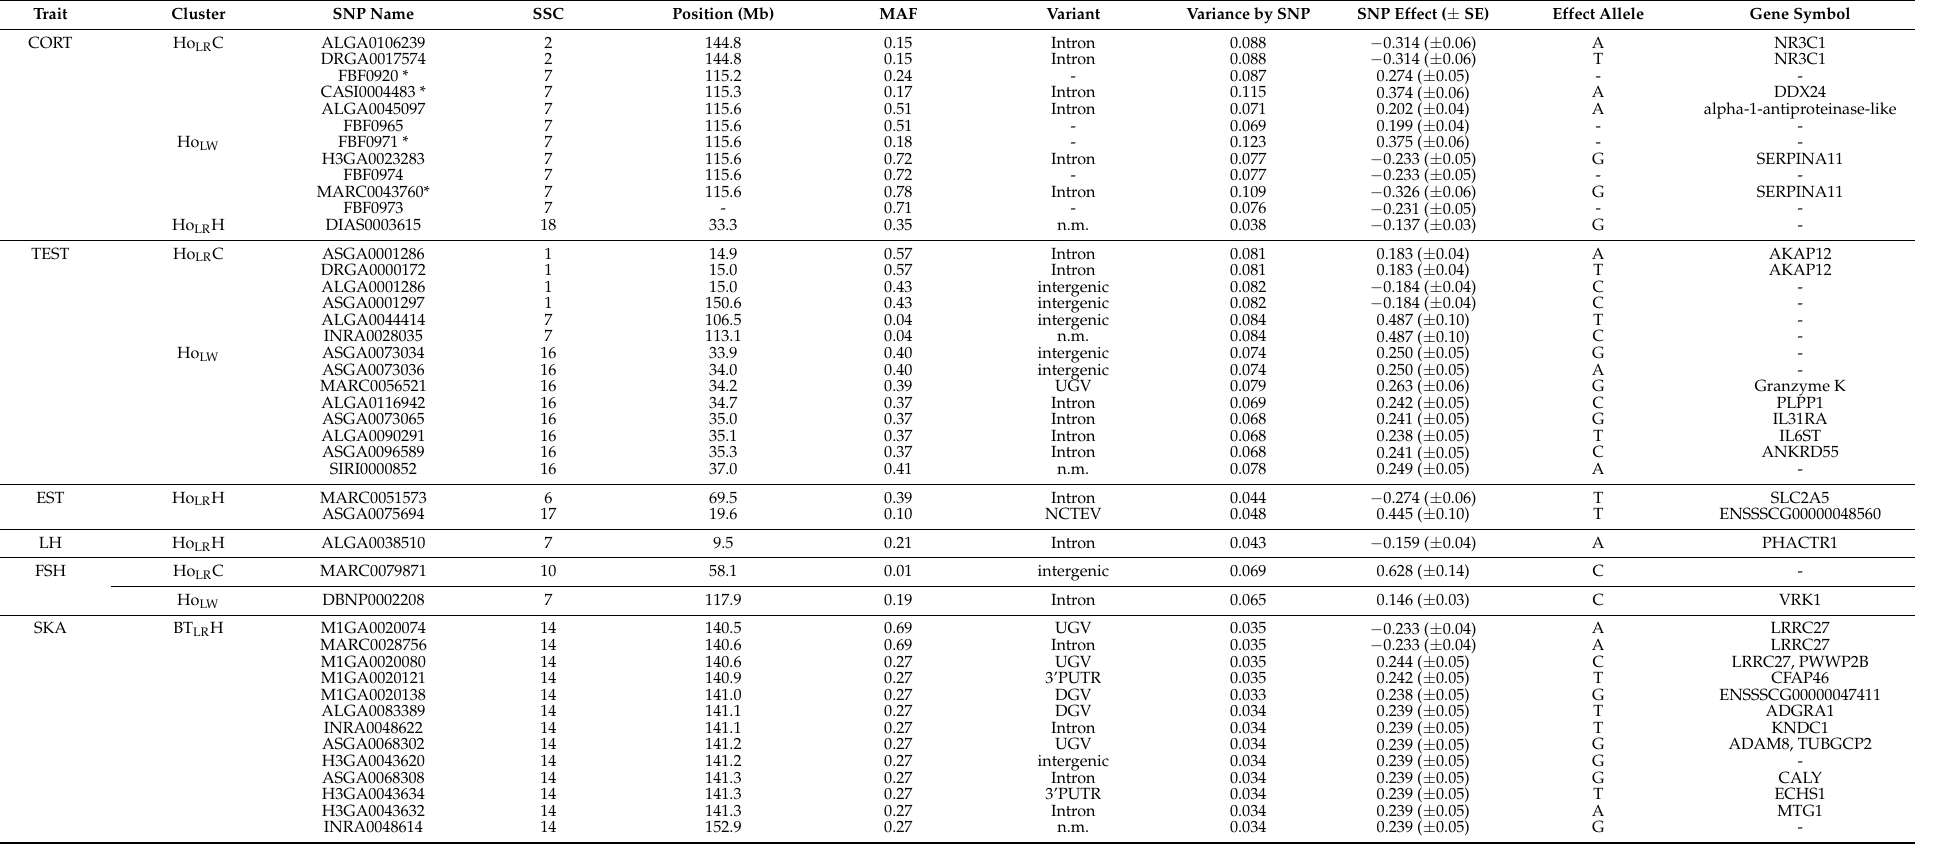
Table 5. Chromosome wide significant marker in clusters after Bonferroni correction ( p <